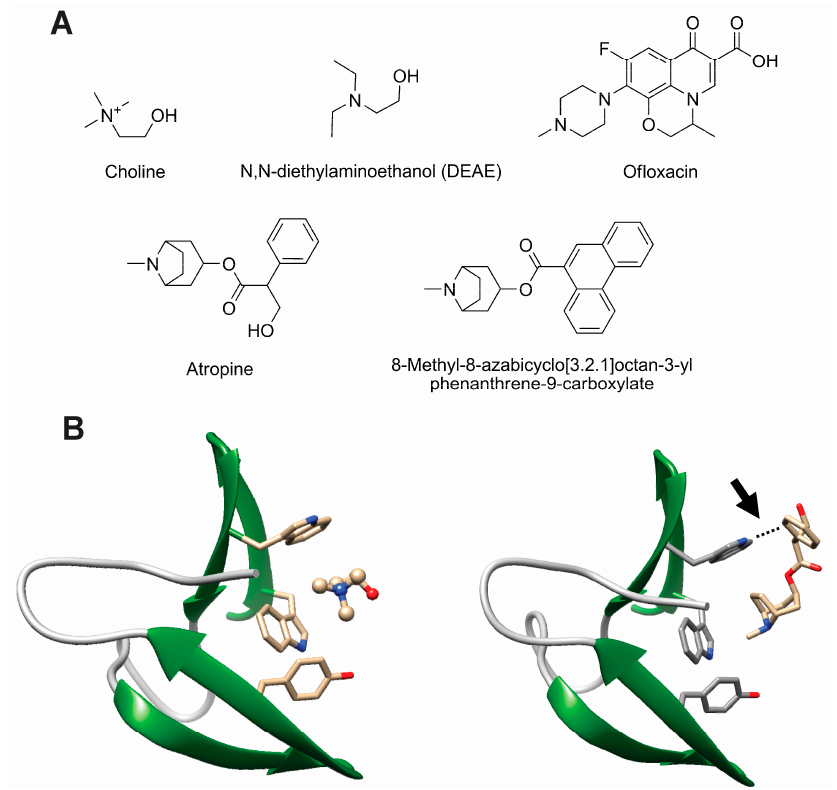
Figure 8. Structure of representative choline analogs that bind to CBPs. ( a ) Chemical formulae of representative compounds; ( b ) Comparison of the same choline-binding site in CbpF occupied by choline ( left , PDB code: 2V04) or by atropine ( right , PDB code: 2X8P); the arrow indicates the additional π - π interaction that provides high stability to CBP-EBA